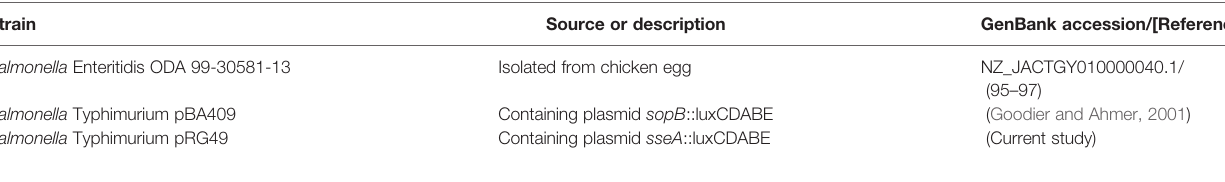
TABLE 1 | Characteristics of Salmonella Enteritidis strains constructs in the current study. Strain Source or description GenBank